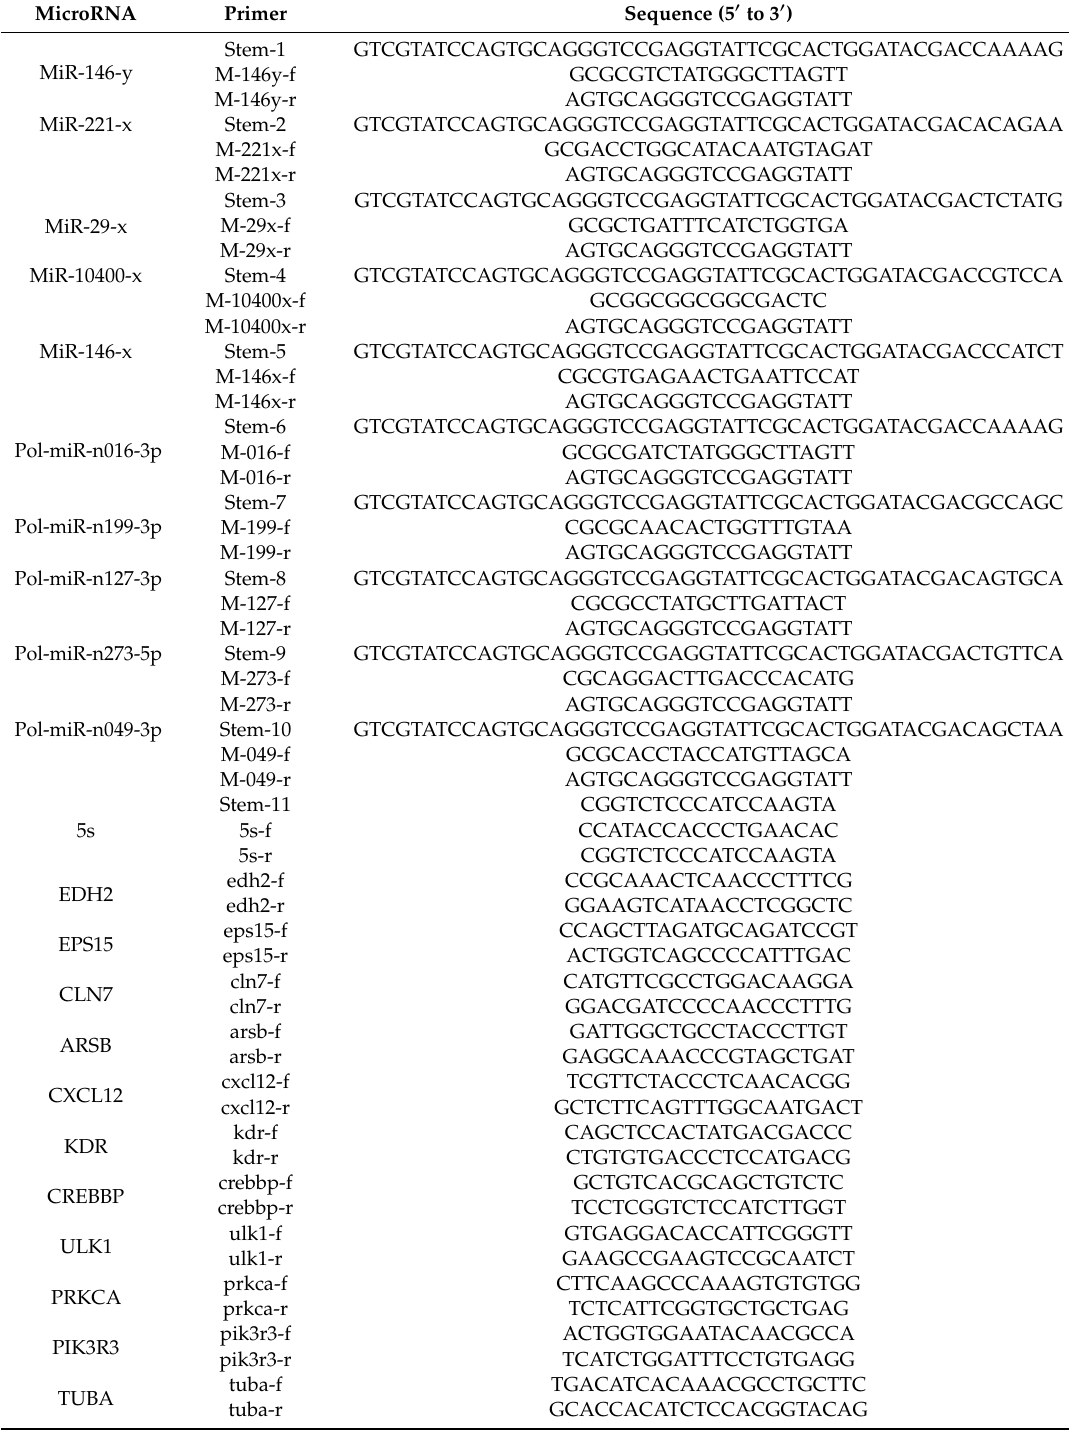
Table 2. List of primers used for stem-loop RT-PCR and qRT-PCR in this study. MicroRNA Primer Sequence (5 (cid:48) to 3 (cid:48)